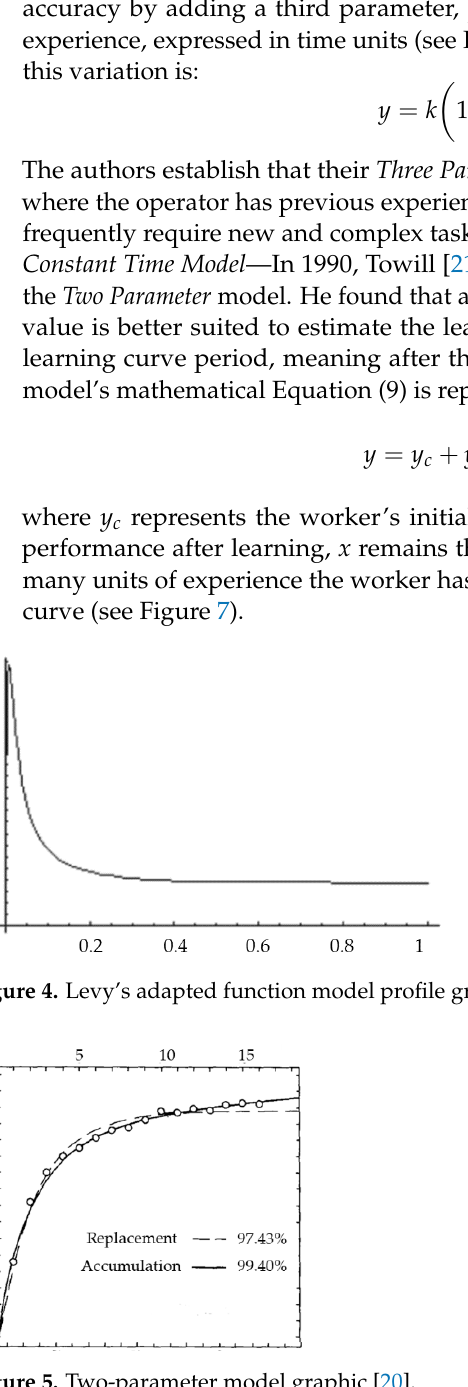
Figure 5. Two-parameter model graphic [20].